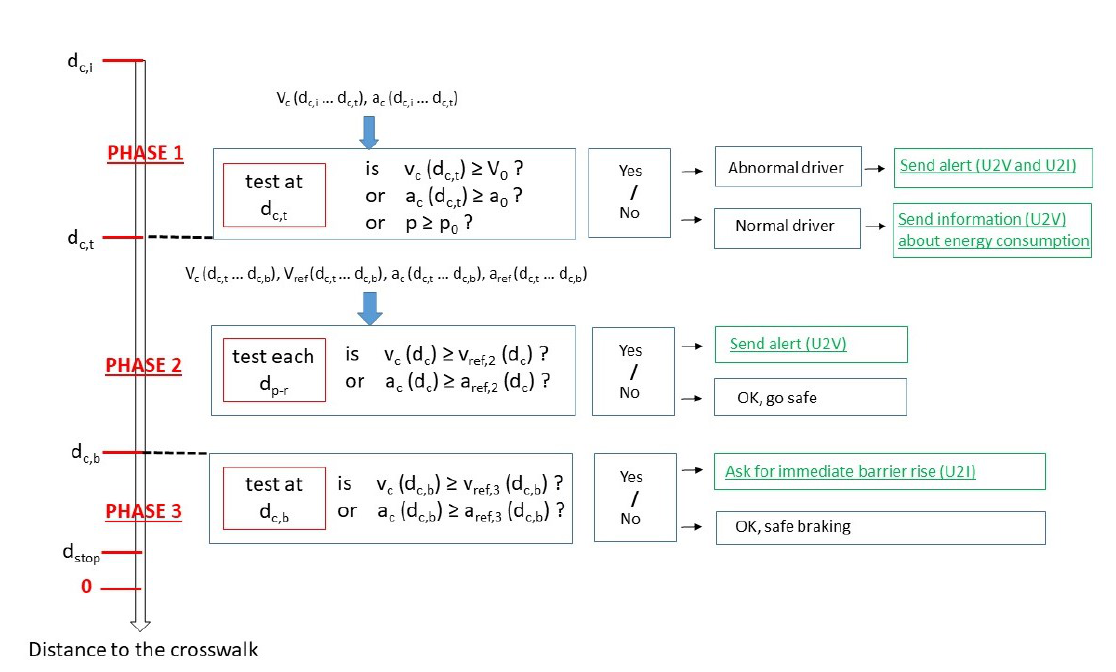
Figure 4. Proposed algorithm consisting in three phases: phase 1 (determining the driver behavior), phase 2 (progressively adjusting the vehicle speed), and phase 3